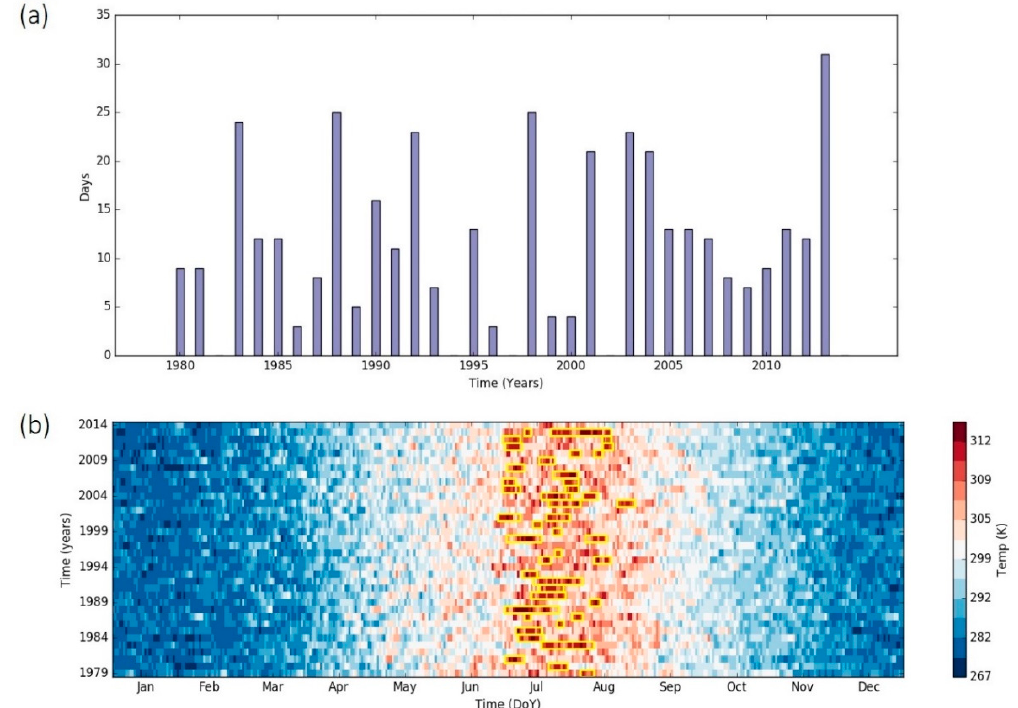
Figure 2. Heat waves in Hangzhou (1 January 1980 to 31 December 2014) by year: ( a ) duration and ( b ) days (yellow boxes) and their maximum temperature. See Section 2.2 for methods.